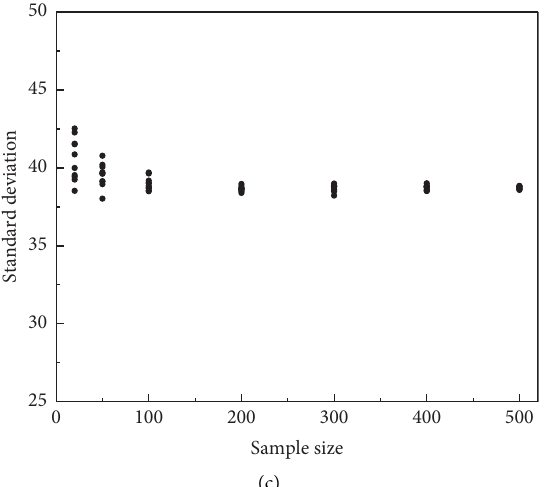
Figure 16: The 10 sets of the standard deviation of the maximum fuel temperature due to the random samples generated by (a) SRS, (b) LHS, and (c) LHS-SVDC.